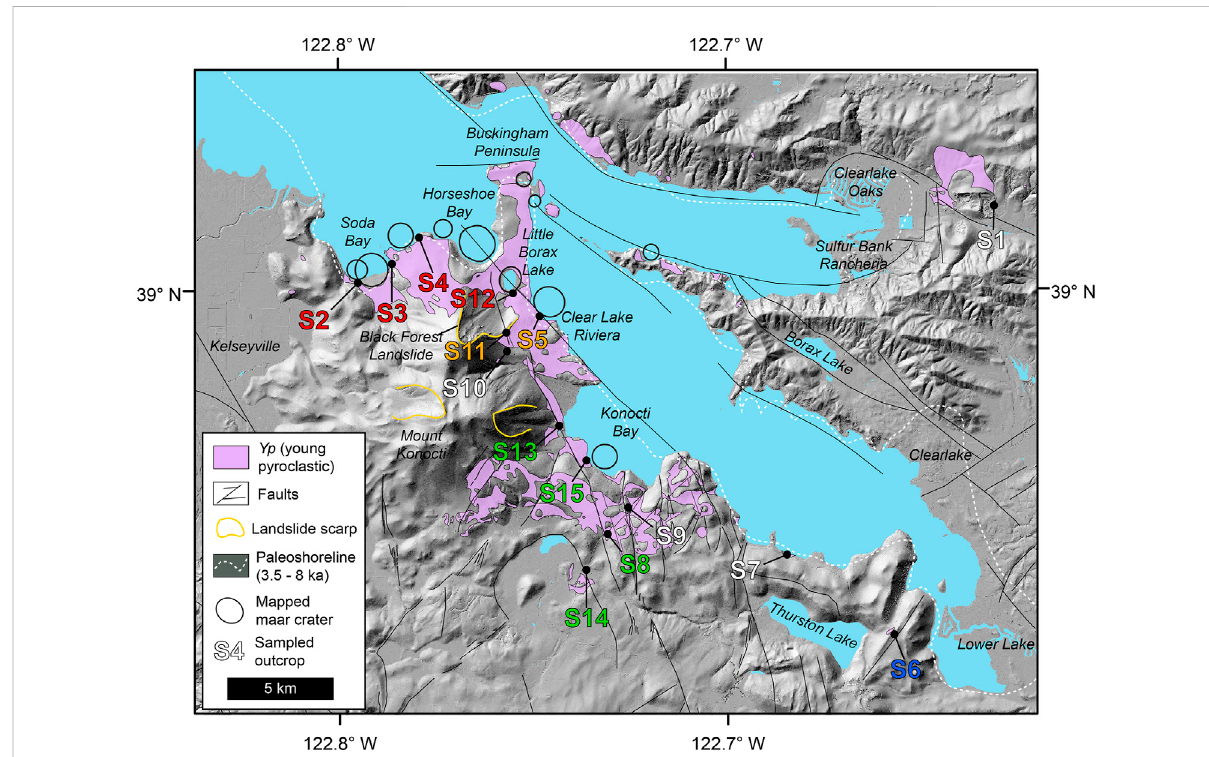
FIGURE 2 “ Youngpyroclastic ” depositandoutcropmapoftheCLVF,focusedontheSEendoftheLake.Outcropssampledforstratigraphy,grain-size,and radiocarbon analysesarenotedwith colorednumbersandblackcircleswithleaders;SodaBayGroupoutcropsareshowninred,Riviera WestGroup in orange, Konocti Bay Group in green, and Lower Lake Group in blue. Known maar craters as mapped by Manson (1989) and Hearn et al. (1995) are markedwithblackcircles,faultsaredepictedwithblacklines,andlandslidescarpsareshownwithyellowlines.ypdepositsofHearnetal.(1995) are in purple. The 3.5 – 8 ka inferred paleoshoreline of Sims et al. (1988) is marked by a white dotted line. Faults are from the USGS Quaternary Fault and Fold Database (U.S. Geological Survey and California Geological Survey, 2022)